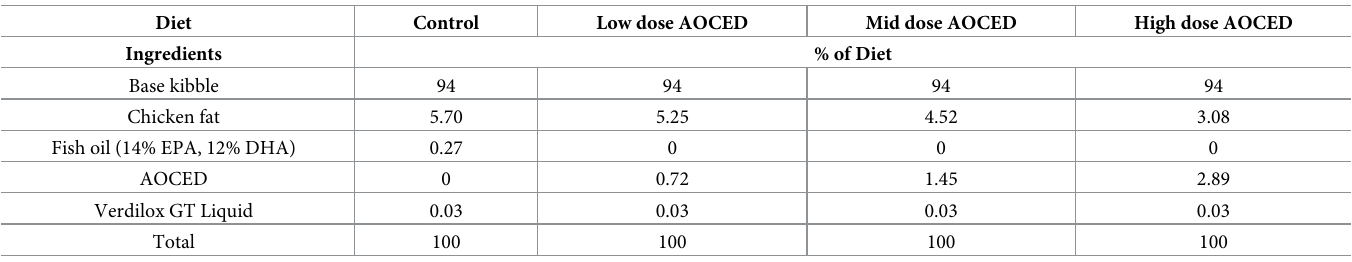
Table 2. Fat composition in the test diets (on as is